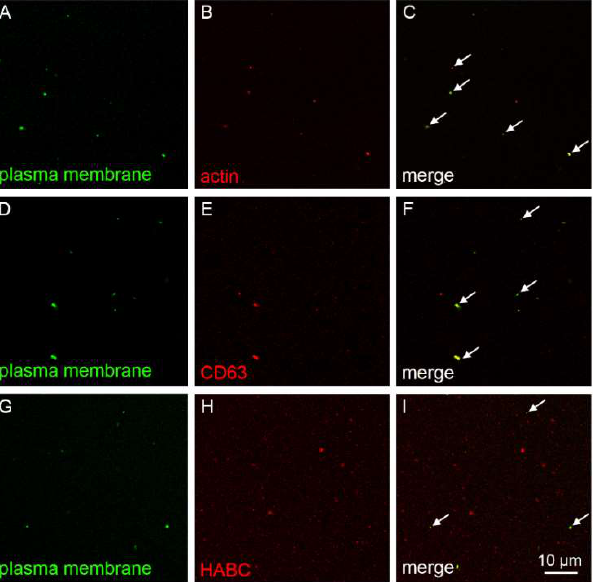
Figure 3. Characterization of extracellular vesicles isolated by ultracentrifugation from fibroblast- like synoviocyte culture medium and stained with CellMask Deep Red plasma membrane stain (pseudocolored green, panels ( A , D , G )), combined with Alexa Fluor 594-labeled phalloidin to detect actin (panel ( B )), Alexa Fluor 488-labeled CD63 (panel ( E )), and Alexa Fluor 568-labeled hyaluronan (HA) binding complex (HABC) to detect HA (panel ( H )), all pseudocolored red. Merged images are shown in panels ( C , F , I ), correspondingly. Arrows in merged images indicate examples of co- localization of the